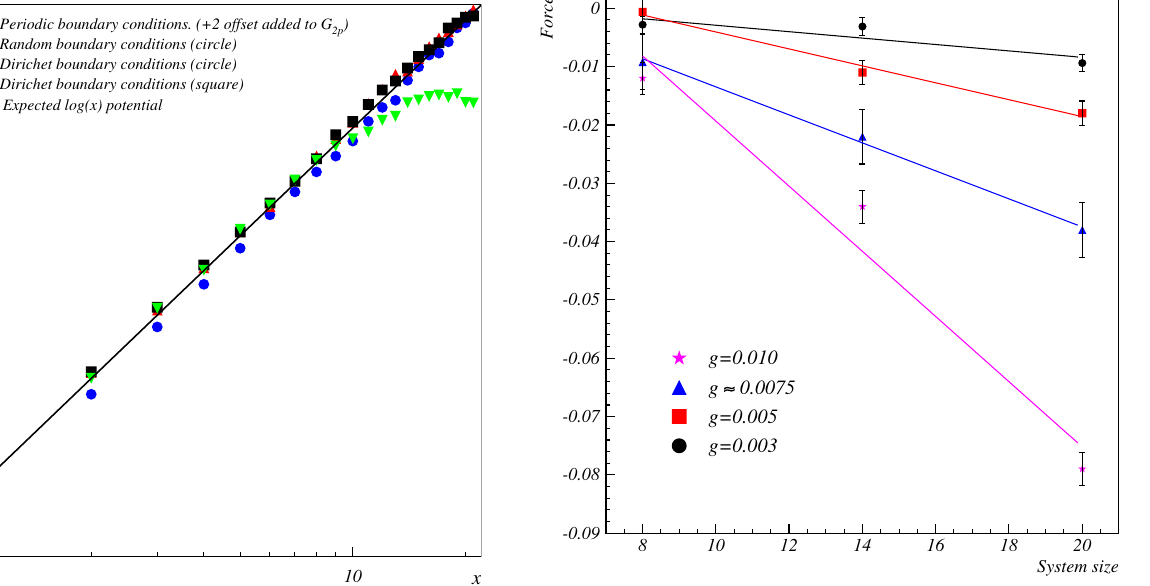
E Dependence on lattice